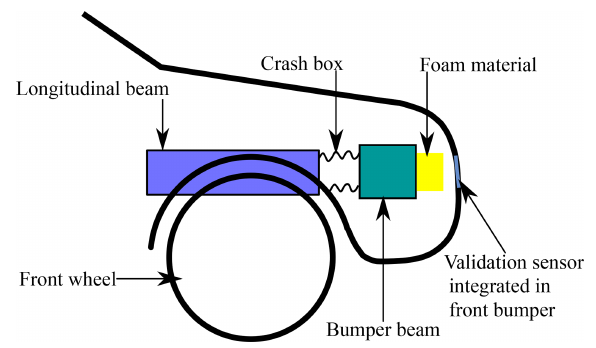
through the circuit I in (which can be calculated from U shunt and R shunt using Ohm’s law) and the measured voltage drop U m over the known resistance ( R known = 1 M (cid:127) ) are continu- ously measured with respect to